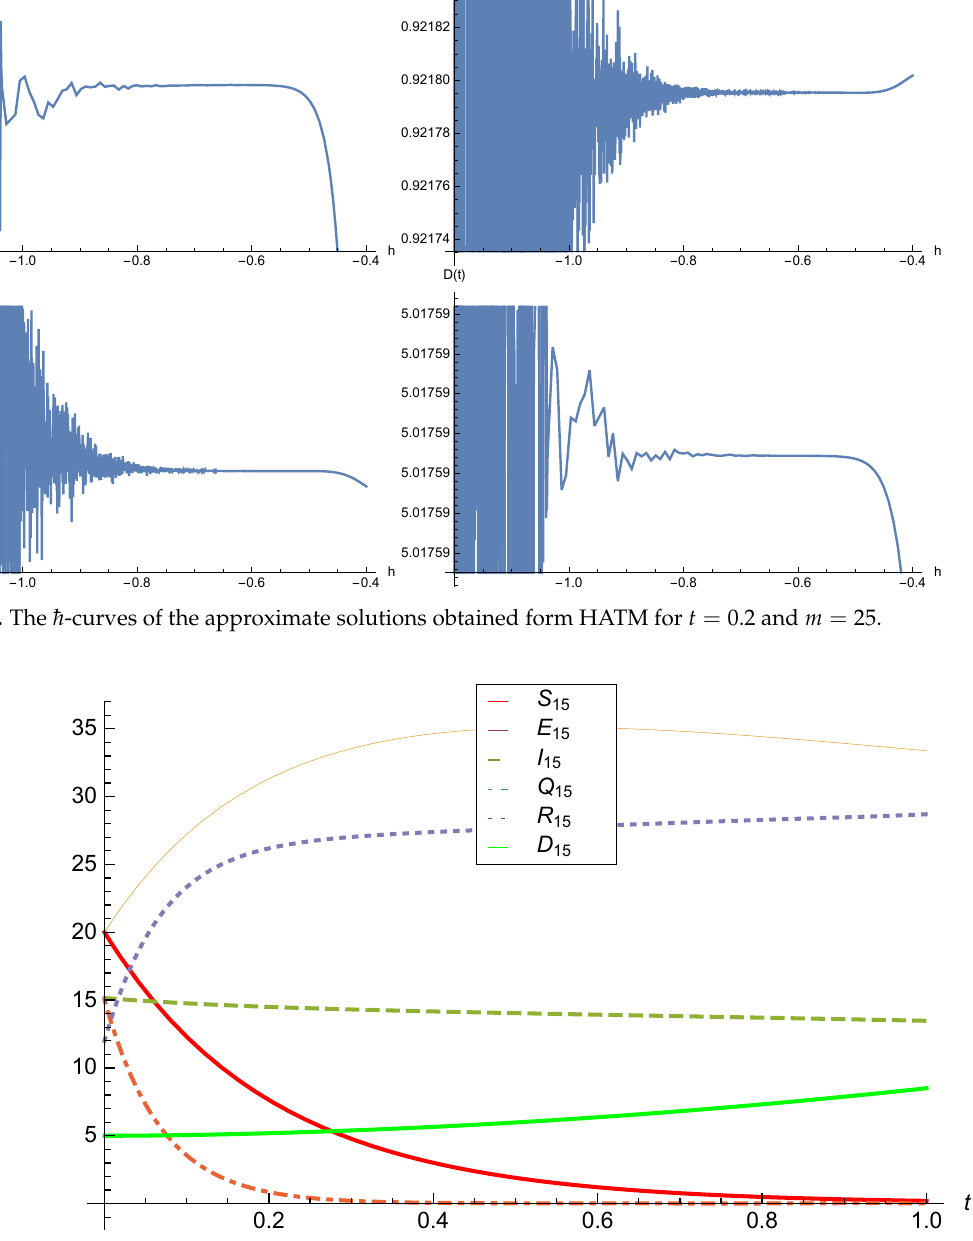
Figure 4. The approximate solution for m = 15, ¯ h = −